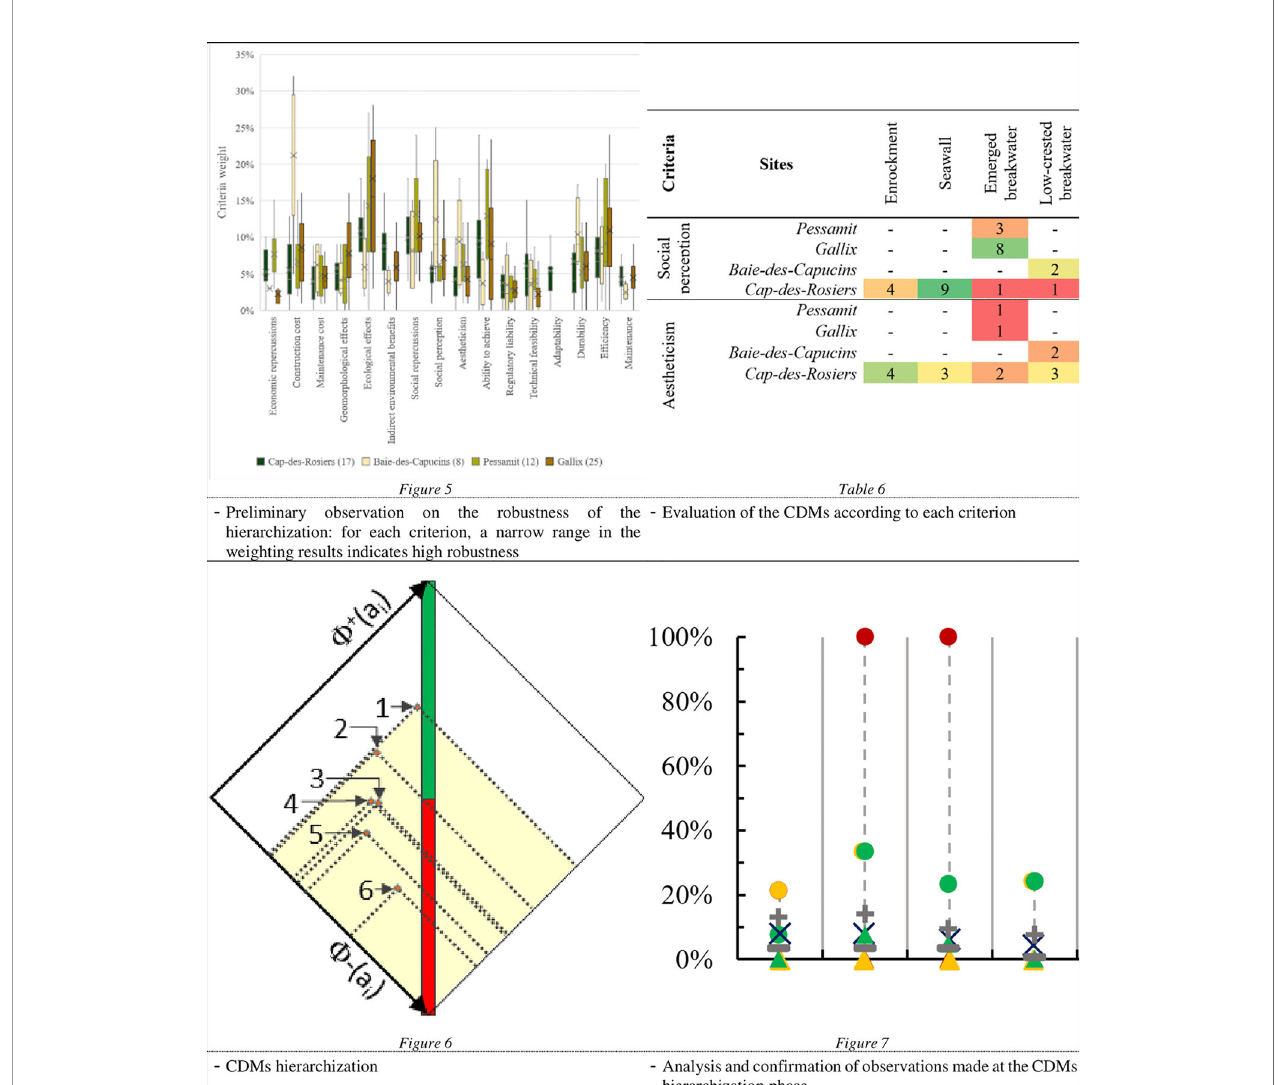
FIGURE 9 | Illustration of the three phases of the MCDA process and robustness analysis in different report